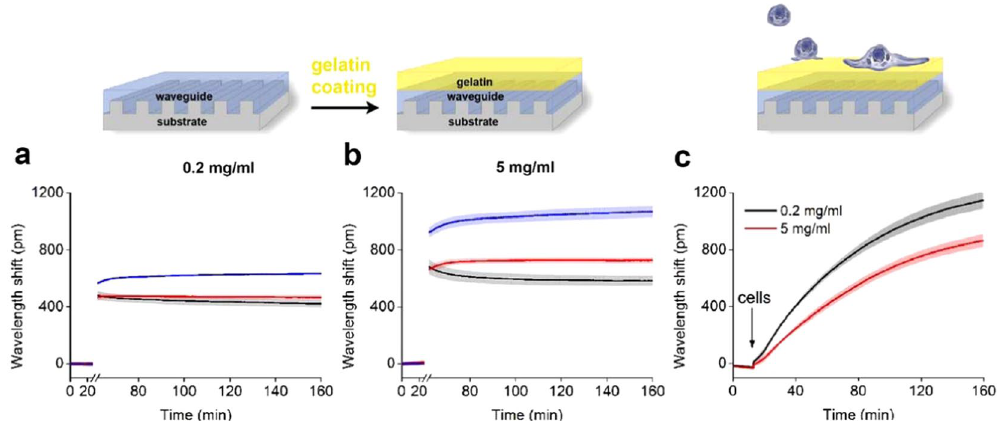
Figure 4. Characterization of sensor coating s by the Epic BT. ( a , b ) Sensor responses after the coating with gelatin ( a 0.2 mg/ml. b 5 mg/ml). Breaks represent 30 min incubation time outside the instrument. Black: washing two times with PBS, Red: replacement of the solution with PBS, Blue: no further treatment. ( c ) Typical cell adhesion curves obtained on gelatin (0.2 mg/ml, 5 mg/ml) coatings after the washing step. At 15 min, 20,000 HeLa cells were pipetted into the wells of the sensor plate in 20 μ l HEPES HBSS buffer, and recorded for 145 min.